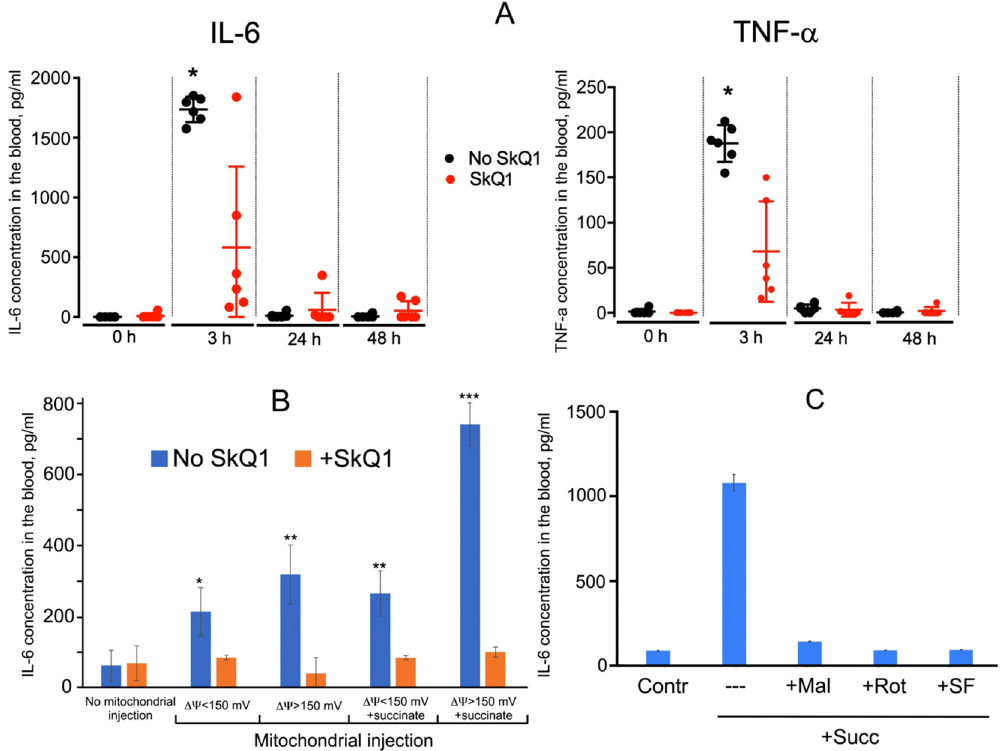
Figure 5. SkQ1 prevents increase in the level of proinflammatory cytokines IL-6 and TNF-α induced by injection of mitochondria. Mitochondria were injected as in Fig. 4. ( A,B ) SkQ1 (1.5 μmol/kg) was administered intraperitoneally daily for 5 days prior to mitochondrial injection. ( B ) Mitochondria isolated as in Fig. 4 and ( A ) were compared with mitochondria isolated in the absence of BSA, which have ΔΨ below 150 mV. Succinate was added to mitochondria prior to injection as in Fig. 4. ( C ) Mitochondria isolated as in Fig. 4 and ( A ) were preincubated with 0.5 mM malonate, 2 μM rotenone or 1 nM SF6847 in the presence of 5 mM succinate prior to injection. Each of the groups contained 6 mice. * p < 0.05. Each of the groups contained 8 mice. In ( A ) the number of mice in each group was 6, and in ( B,C ) in each group 8. * p < 0.05, ** p < 0.01, *** p <